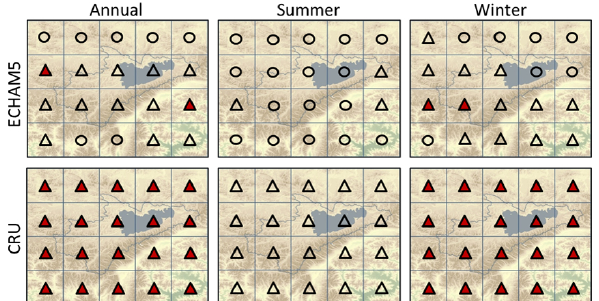
Fig. 4. Mann-Kendall trend test results for annual, summer and win- ter temperature of ECHAM5 (top) and CRU (bottom) for the pe- riod 1981–2004 ( 4 /red 4 = significant/highly significant increasing trend with p = 80%/95%; (cid:13) = no significant